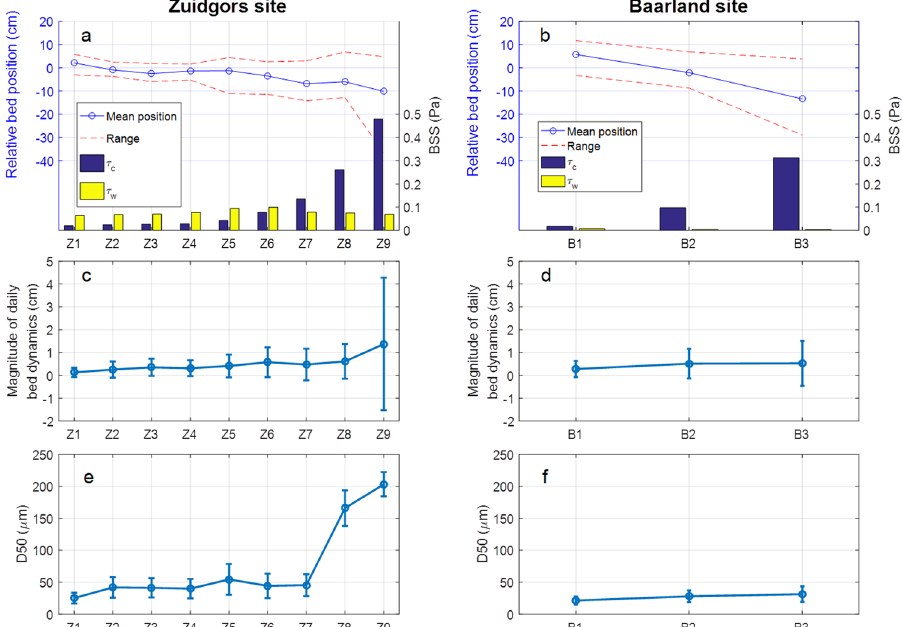
Figure 3. Spatial distribution of relative bed-level positions, τ c and τ w (panel a and b), magnitude of daily bed-level dynamics (panel c and d), and median sediment grain diameter (D50) (panel e and f) at the exposed Zuidgors and sheltered Baarland site. The relative bed-level positions are comparing to the starting position at ‘0’, which indicates overall spatial morphodynamic trends. The bed-level at the start of the measurements is at ‘0’. The positive and negative values indicate deposition and erosion, respectively. τ c and τ w are the average values of daily BSS at each station (e.g. Fig. 2a and b). The magnitude of daily bed-level dynamics reflects the mean level of absolute bed-level changes, and the error bars indicate the standard deviation of this magnitude due to temporal variation. D50 was measured by monthly by collecting and analysing surface sediment (top 2 cm) at each station. The error bars indicate the standard deviation of